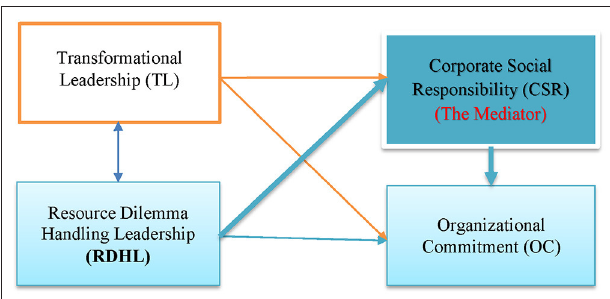
FIGURE 1 | Research framework of this study (The key mediating role of CSR in helping RDHL to promote the level of organizational sustainability).